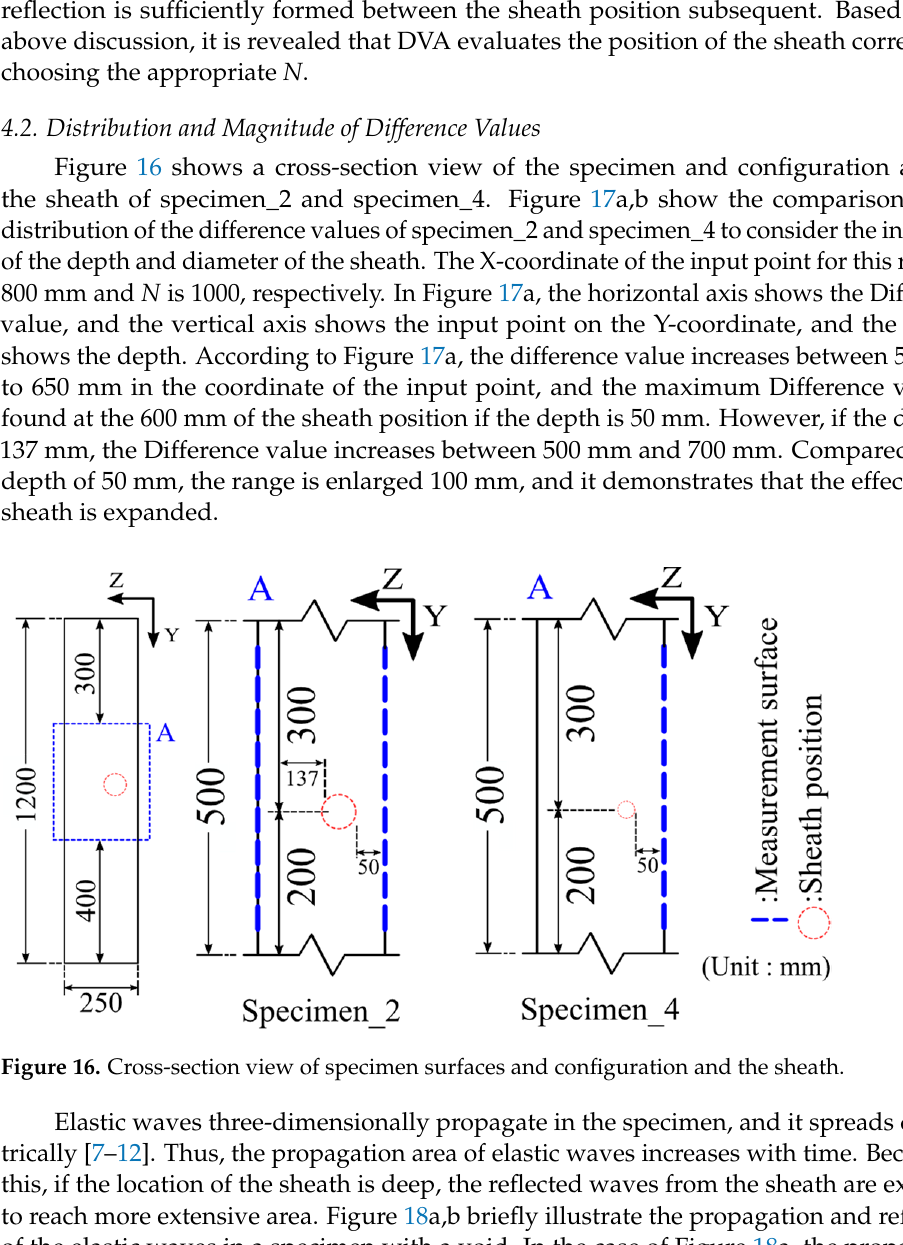
Elastic waves three-dimensionally propagate in the specimen, and it spreads concen- trically [7–12]. Thus, the propagation area of elastic waves increases with time. Because of this, if the location of the sheath is deep, the reflected waves from the sheath are expected to reach more extensive area. Figure 18a,b briefly illustrate the propagation and reflection of the elastic waves in a specimen with a void. In the case of Figure 18a, the propagation area is narrow because the distance between the measurement surface and the void is short. In contrast, in the case of Figure 18b, the distance between the measurement surface and sheath is longer, and the reflected wave from the sheath spreads wider. Finally, the response is affected widely on the measurement surface if the location of the void is deep. Therefore, if the location of the void is deeper, the Difference value increases over a